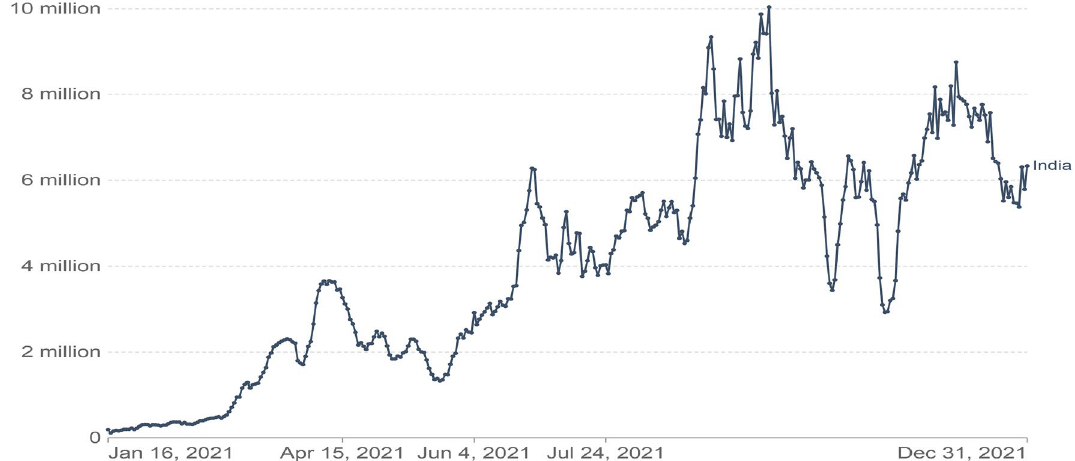
Figure 8. The number of people vaccinated reported over the period of time.